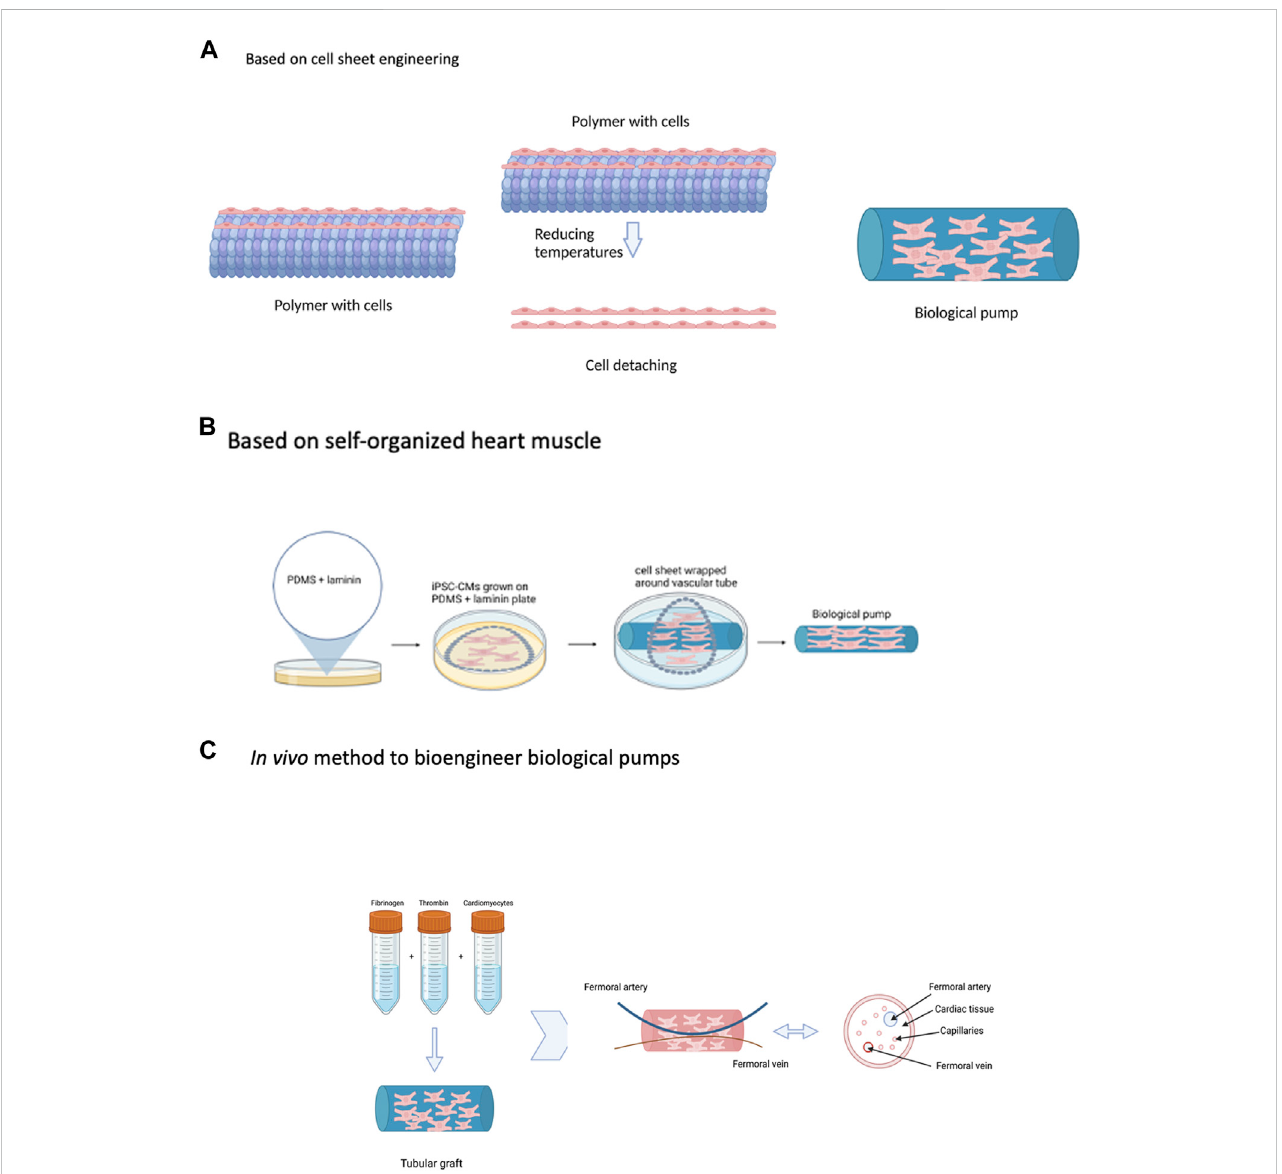
FIGURE 4 Strategies to Bioengineer Biological Pumps — (A) Based on cell sheet engineering. (B) Based on self-organized heart muscle. (C) In vivo method to bioengineer biological pumps. Created with BioRender.com.